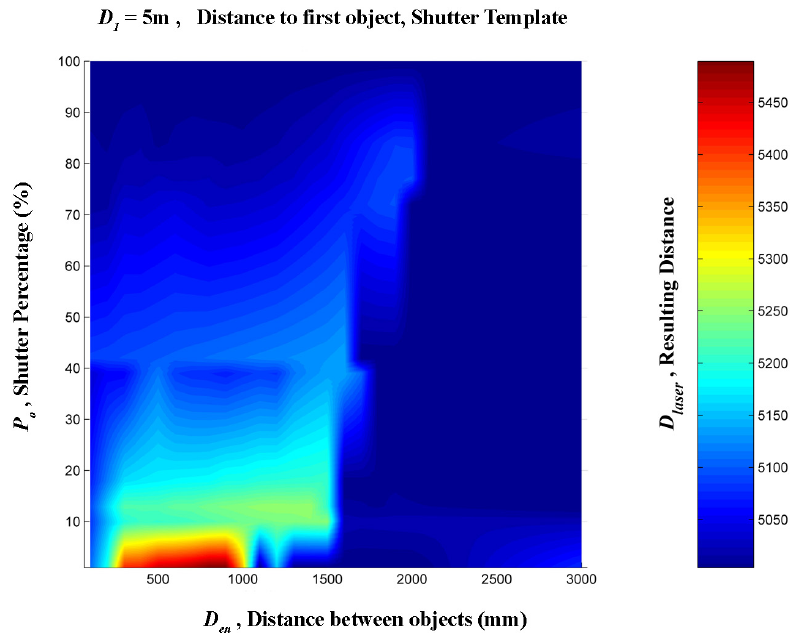
Figure 19. Graphic representation of the distance values (D the results of the progressive blockage of the beam at 90° with the shutter template at a distance (D ) of 5,000 mm from the sensor, with different values of D 1 and 3,000 mm.